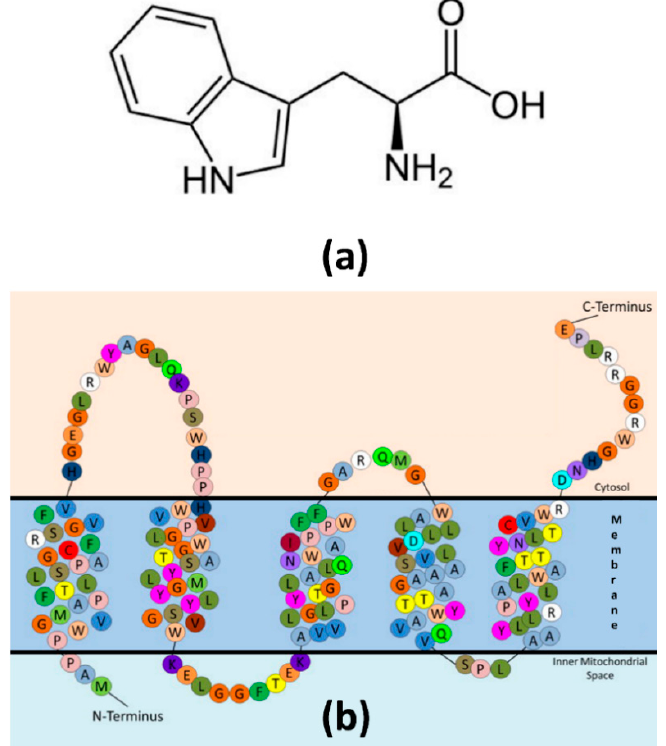
Figure 3. Neurospecific molecules with strong brain-periphery correlation. ( a ) Tryptophan. ( b ) Topo- logical model of human TSPO reproduced from [58], Copyright © 2013, with permission from Elsevier and corresponding author Professor Louis M. Rendina. The figure of TSPO in [58] was adapted from [59].